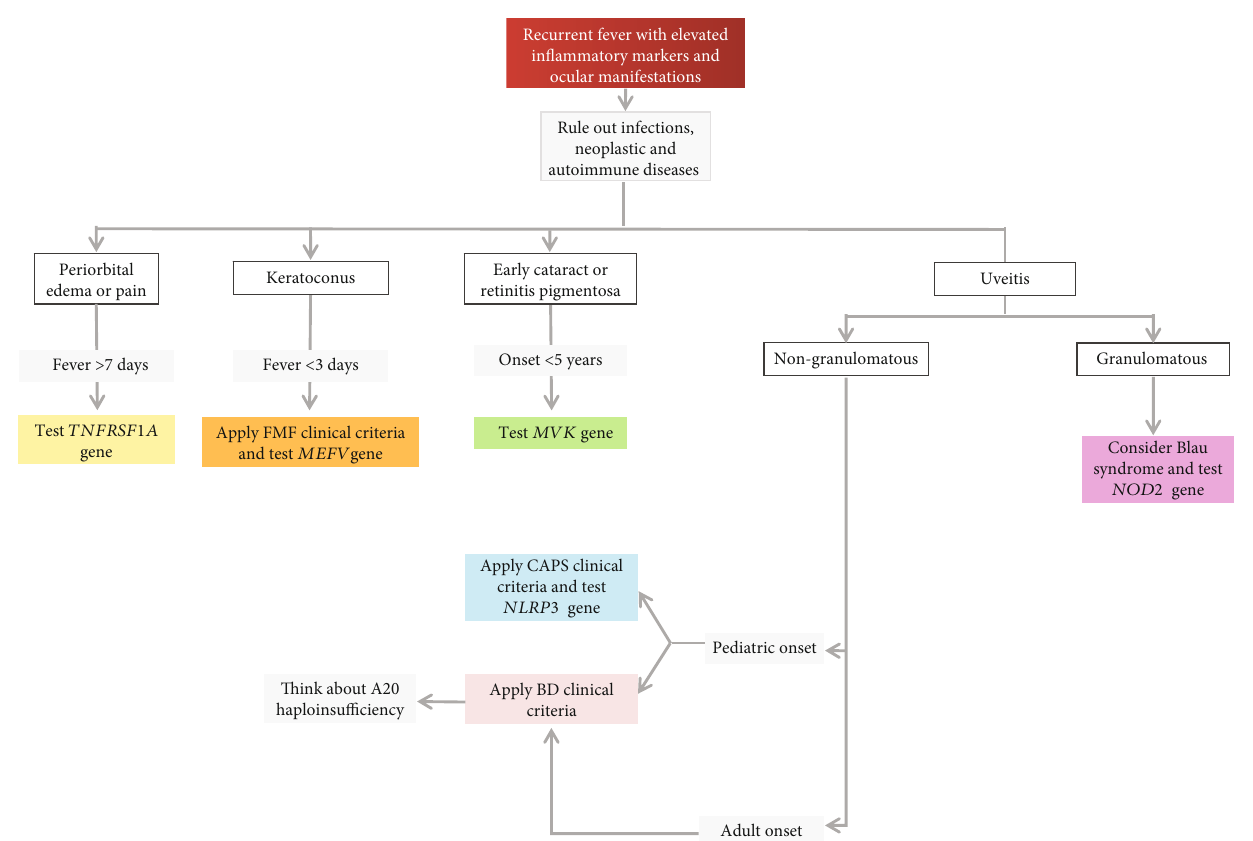
Figure 4: Diagnostic fl ow chart for main autoin fl ammatory diseases displaying recurrent fevers and ocular manifestations. List of abbreviations: FMF — familial Mediterranean fever; BD — Behçet ’ s disease; CAPS — cryopyrin-associated periodic